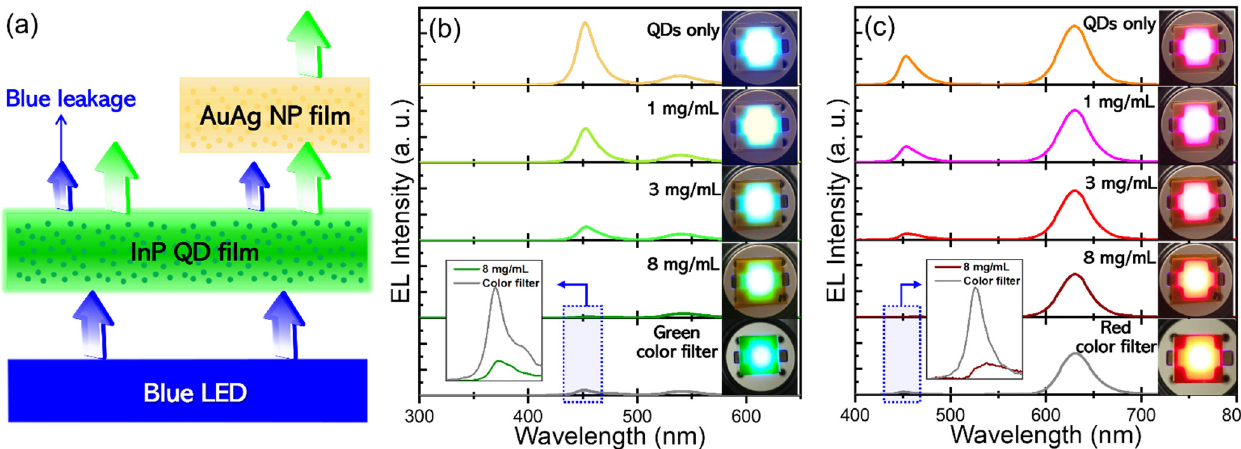
Figure 4. ( a ) Schematic illustrating the effective suppression of blue light leakage by the presence of AuAg NP polymeric film atop, ( b ) EL spectra and corresponding EL images of green, and ( c ) red QD-PDMS films integrated with AuAg NP-PMMA overlayers with different AuAg NP concentrations on a 5 mA-driving blue LED. Degrees of blue light leakage upon applying AuAg-PMMA film with the highest AuAg NP concentration (8 mg/mL) versus conventional LCD ( b ) green, and ( c ) red color filters were also compared (refer to the magnified plots of the insets of ( b , c ), corresponding to blue-dotted rectangles).